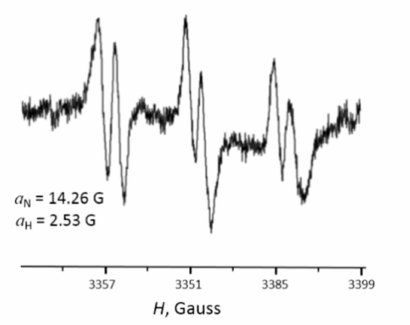
Figure 10. EPR spectrum of the spin adduct from the reduction of 7 at a Pt electrode (E = − 0.9 V) in the presence of N- t -butyl- α -phenylnitrone (PBN). AN/0.1 M Bu 4 NPF 6